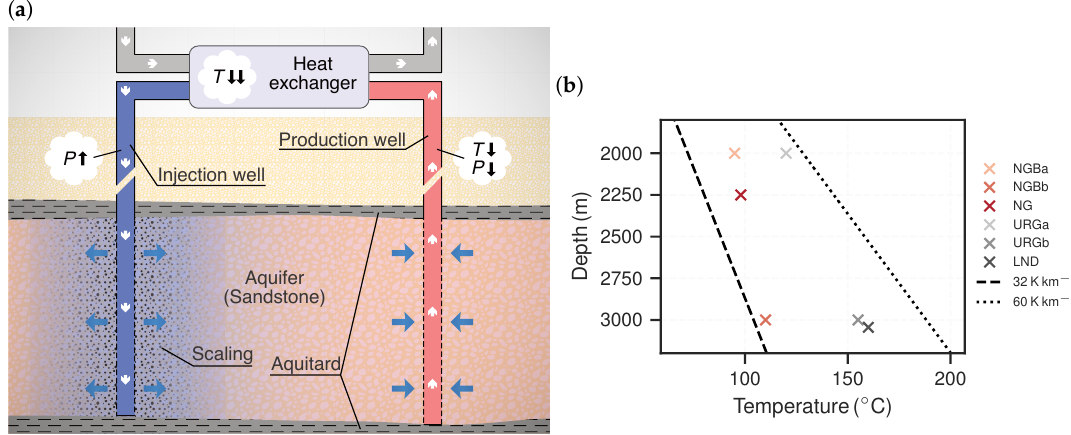
Figure 1. ( a ) Schematic diagram of a geothermal doublet, showing the core technical installations consisting of a production and an injection well, as well as a heat exchanger. Brine temperature ( T ) and pressure ( P ) change along the flow path. Scalings at the injection site clog the pores, which results in reduced injectivity. ( b ) Fluid temperatures at respective depths for the test cases Neustadt-Glewe (NG), Landau (LND) as well as for the hypothetical sites in the North German Basin (NGB) and the Upper Rhine Graben (URG) (Table 1). The dashed line represents the average geothermal gradient for Germany